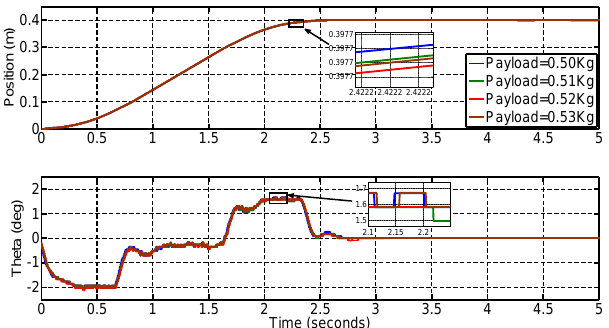
Figure 12. The time-optimization response within a time-optimal scheme. Table 6. Performance within a time optimal solution.